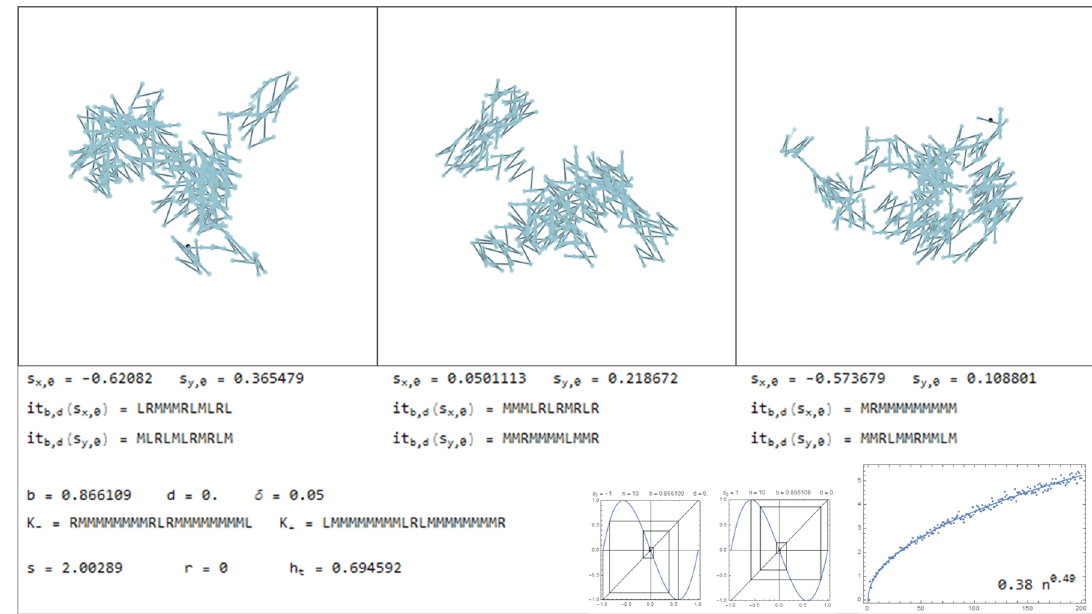
Figure 15. Trajectories produced with b = 0.866109 and d =